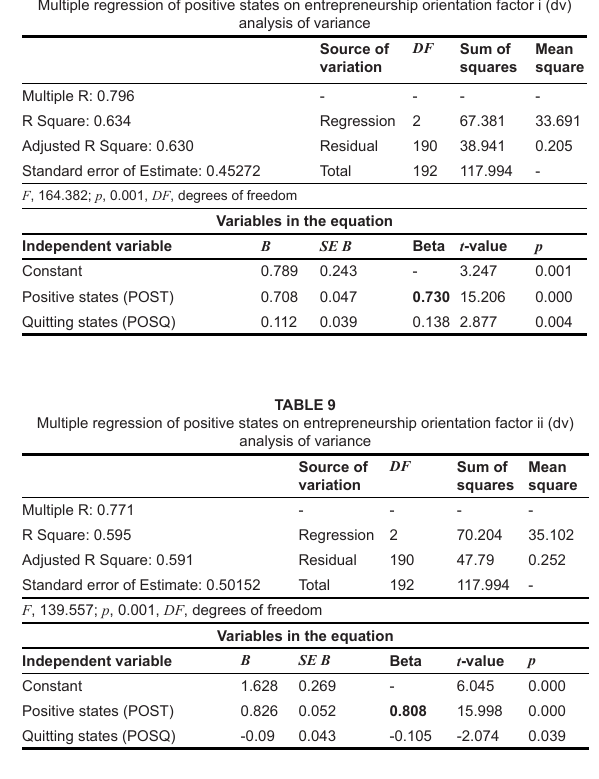
Multiple regression of positive states on entrepreneurship orientation factor i (dv)